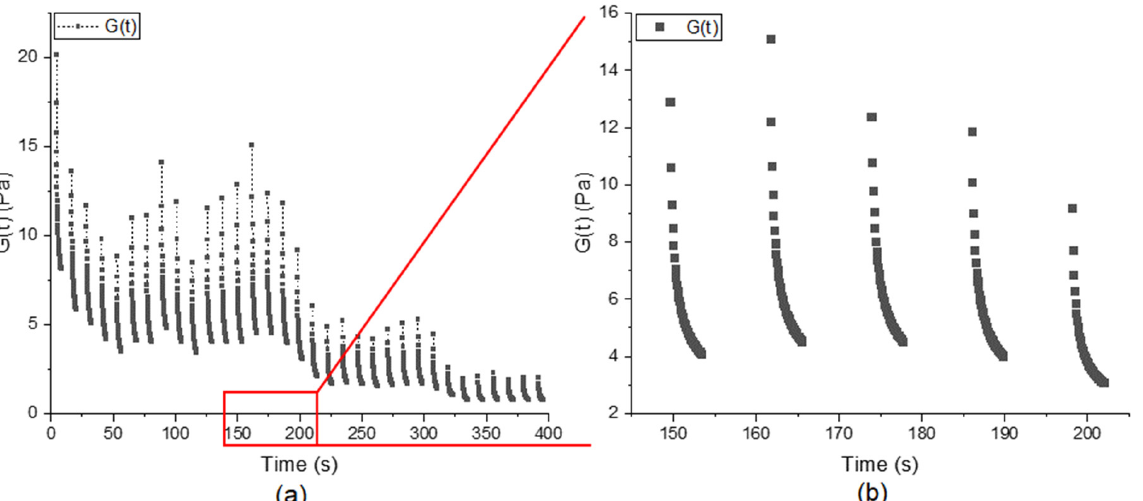
Figure 4. ( a ) Decrease in G ( t ) during the relaxation steps for standard wheat flour and water [n = 1] as an example of the shear kneading process over the whole 400 s kneading process. ( b ) Zoom in on the exponential decrease in values for the relaxation steps from 150 s to 200 s kneading time.